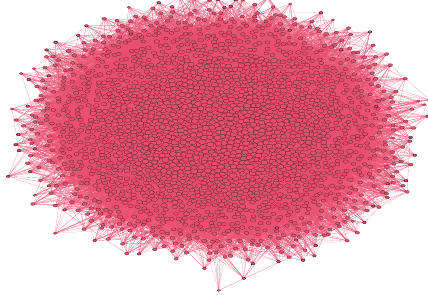
Figure 4: The Sample network